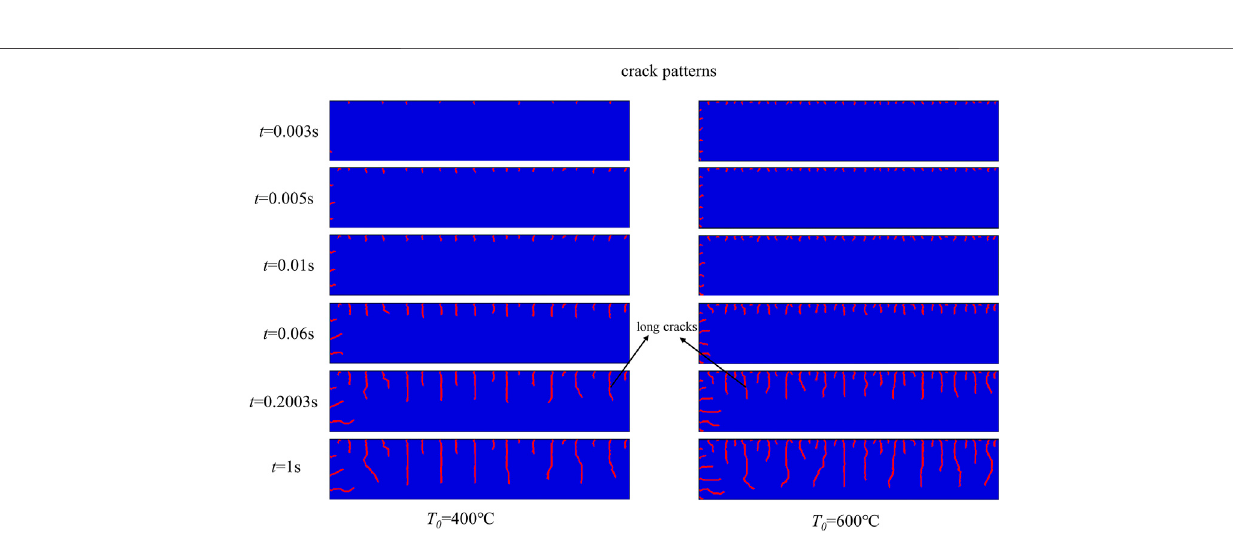
spacing. The cracks show periodicity and hierarchy. Short cracks appear between every two long cracks. Consequently, the numerical simulation results are in good agreement with the